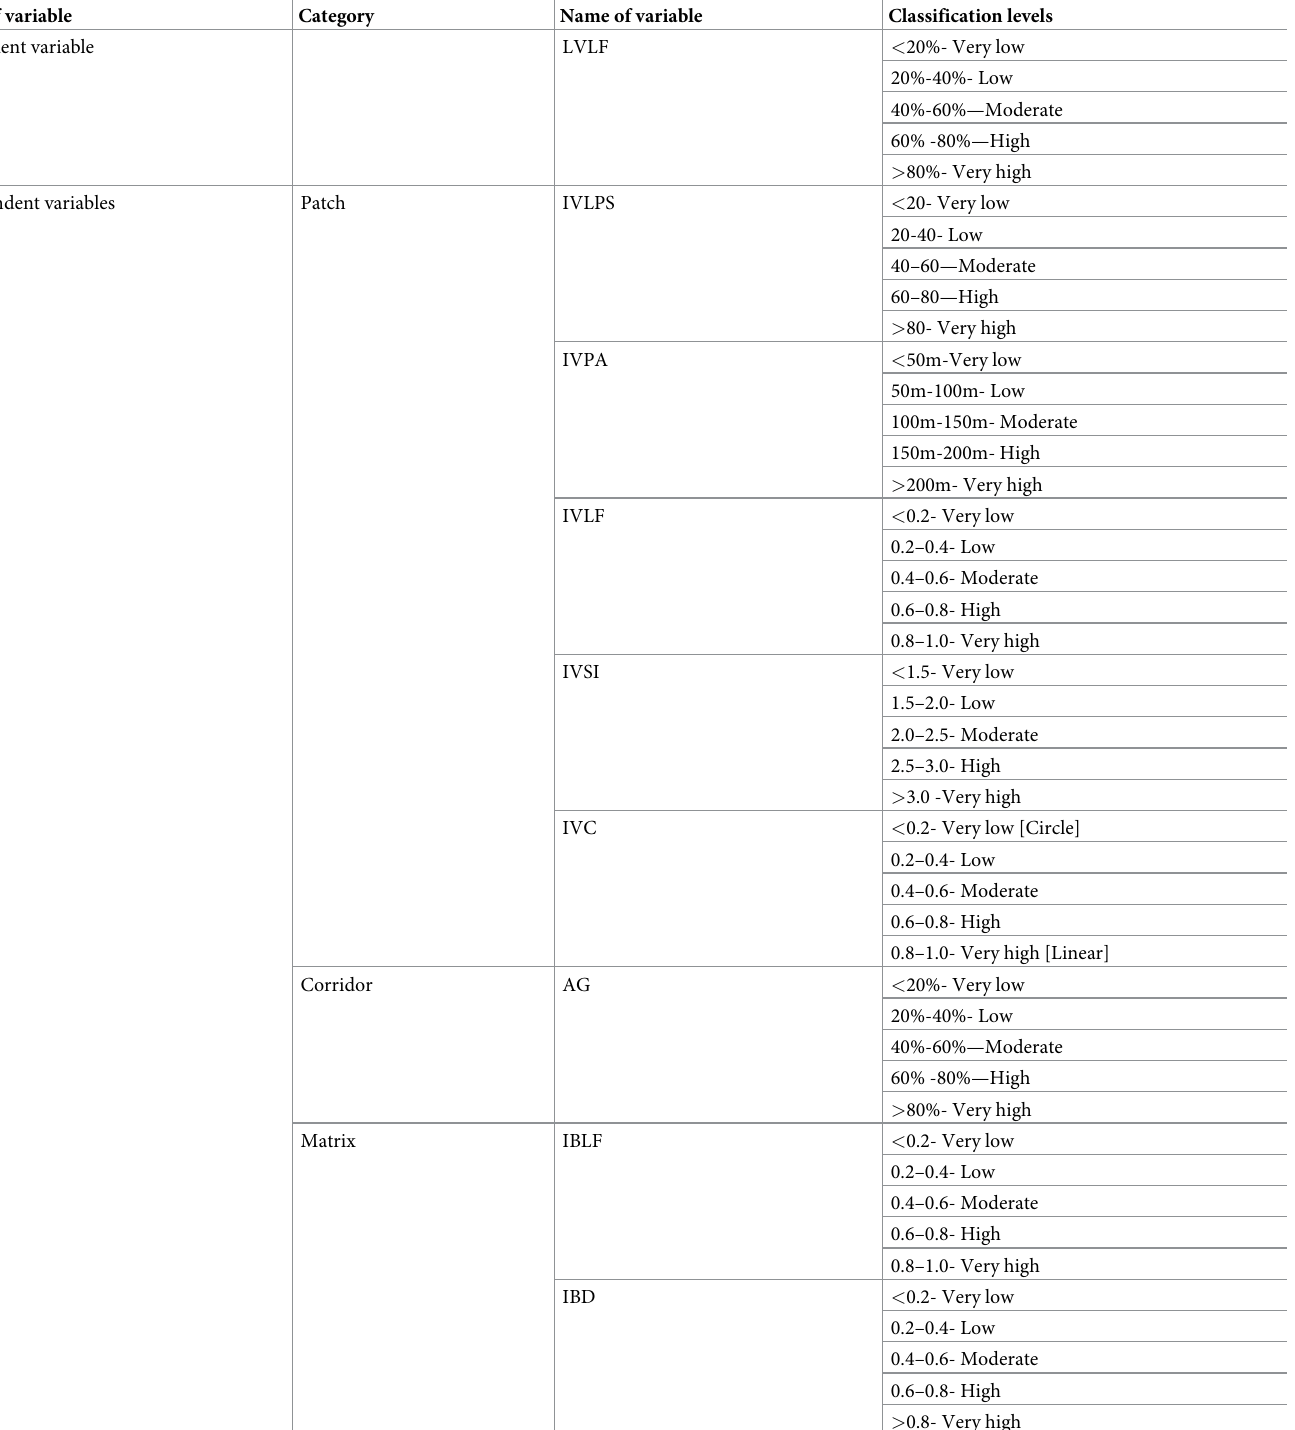
Table 2. Numeric values of variables’